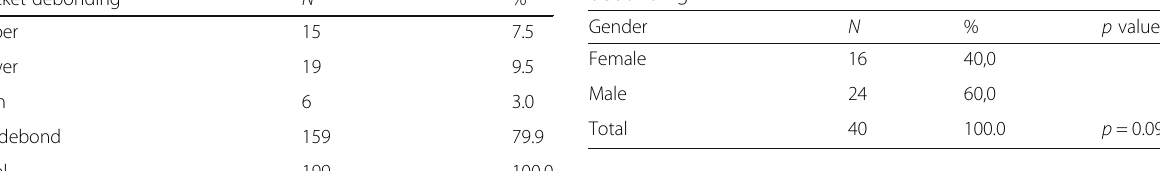
Table 3 Comparison between patients ’ gender and bracket